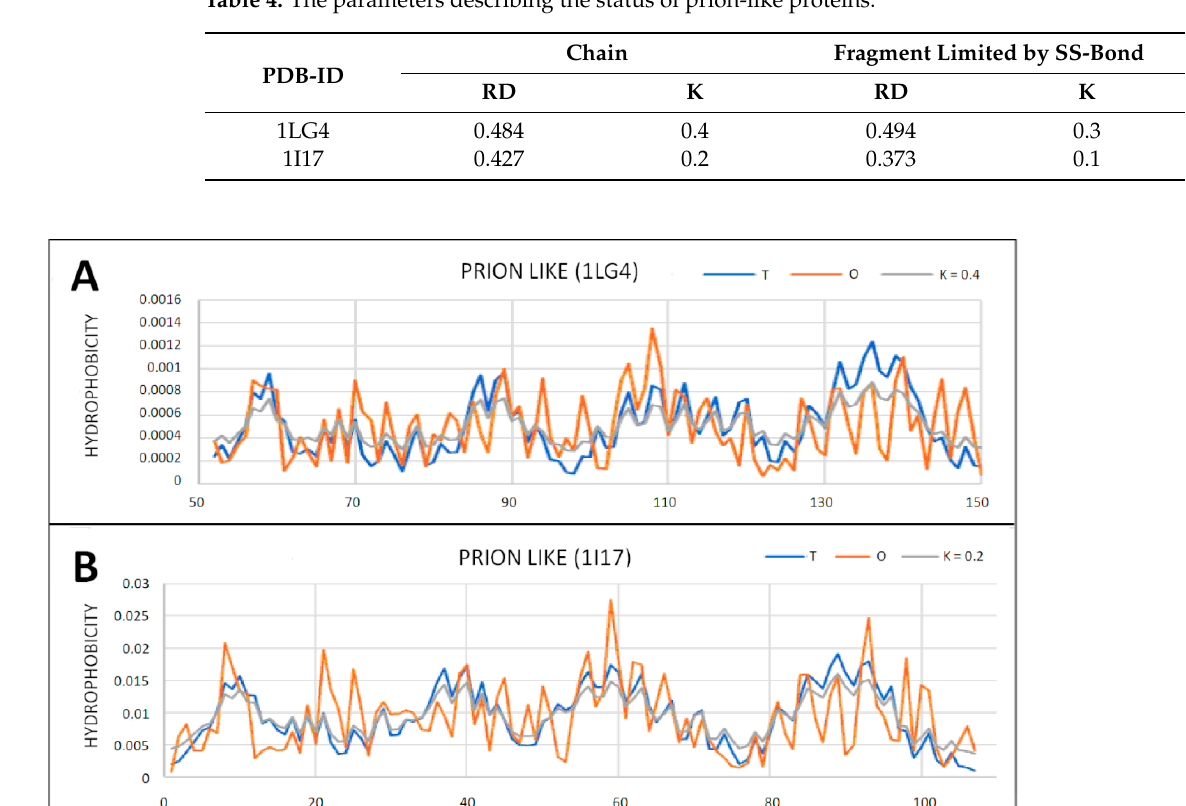
Figure 9. Different hydrophobic core organization in ( A ) monomer and ( B ) dimer as observed in 4HLS.